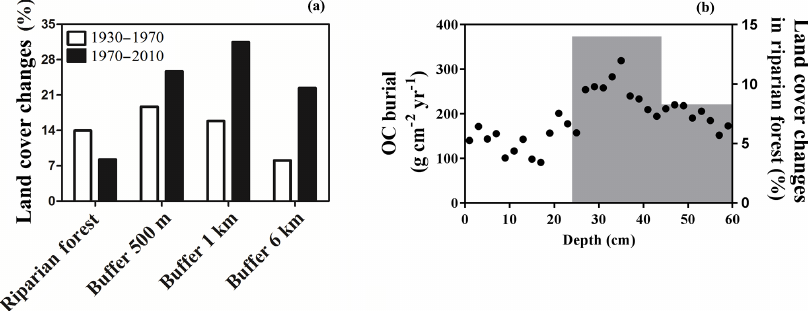
Figure 8. Percentage of modified areas in relation to the different buffers (a) . Carbon burial (black dots) and changes in the riparian vegetation (the two grey bars represent the two general phases) as related to time (b)